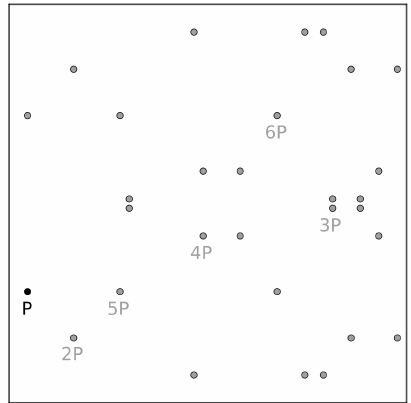
Figure 2. E 0,7 ( F 43 ) with some multiples of the distinguished point P = ( 2,12 )